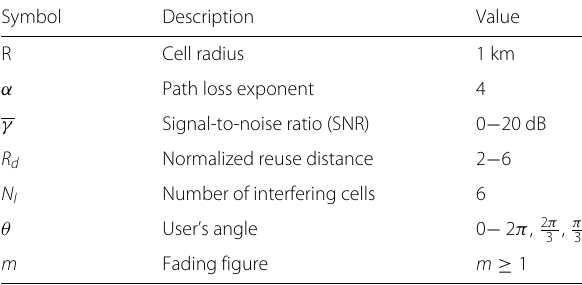
Table 1 Parameters used for simulation of SE, EE, SSE, and SEE Symbol